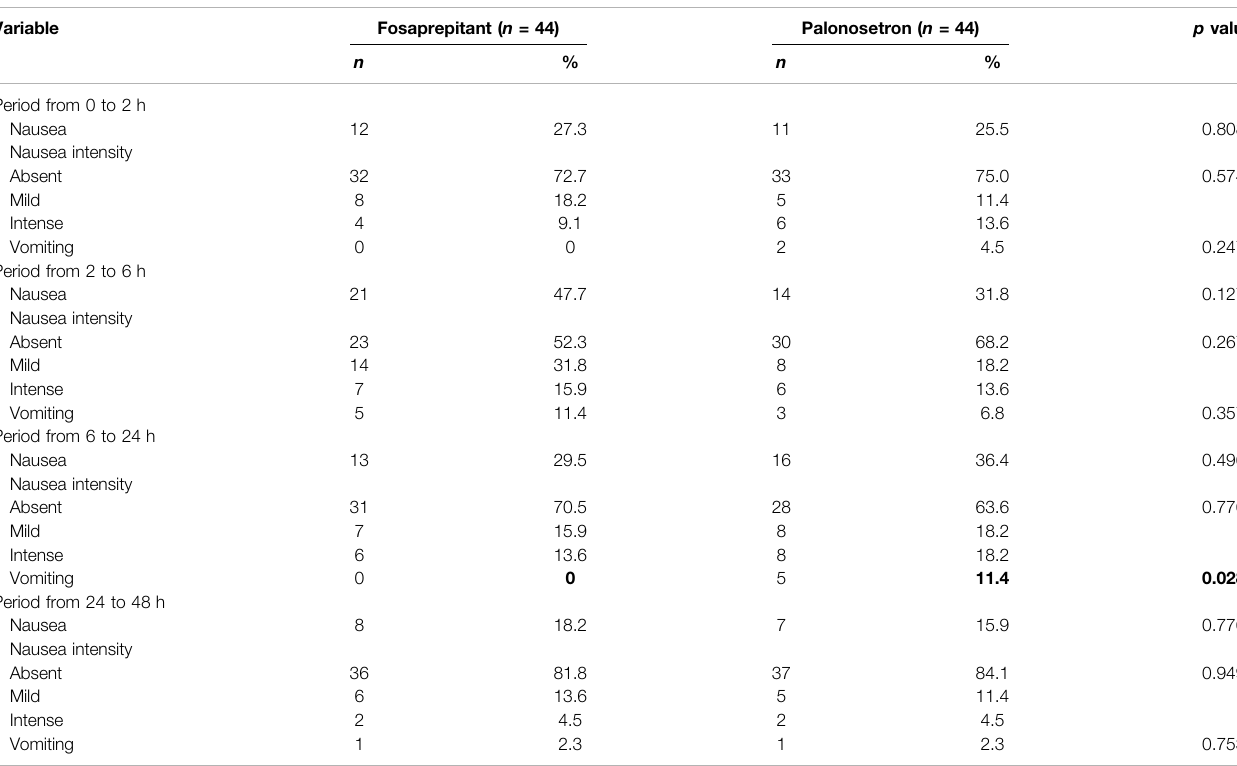
TABLE 2 | Nausea and vomiting during the four evaluated periods.